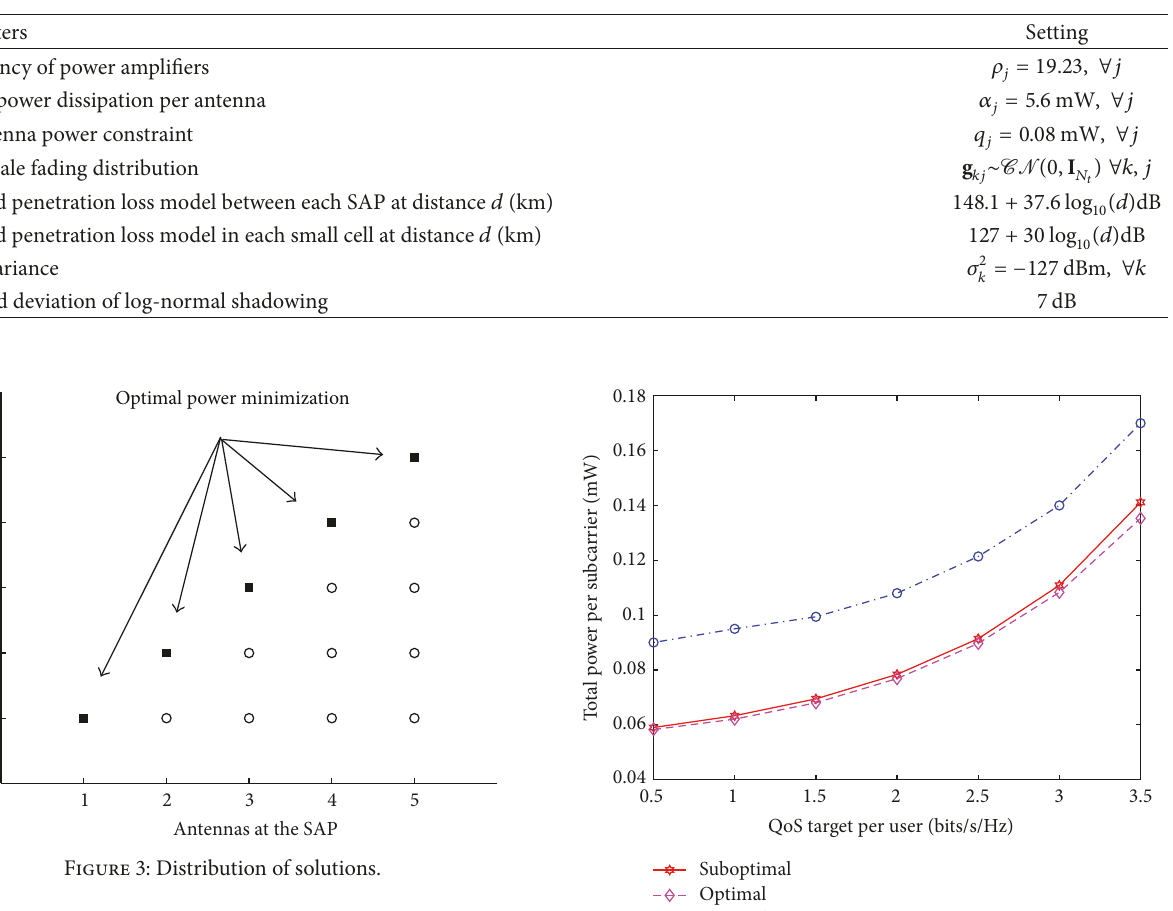
Table 1: Simulation parameters.